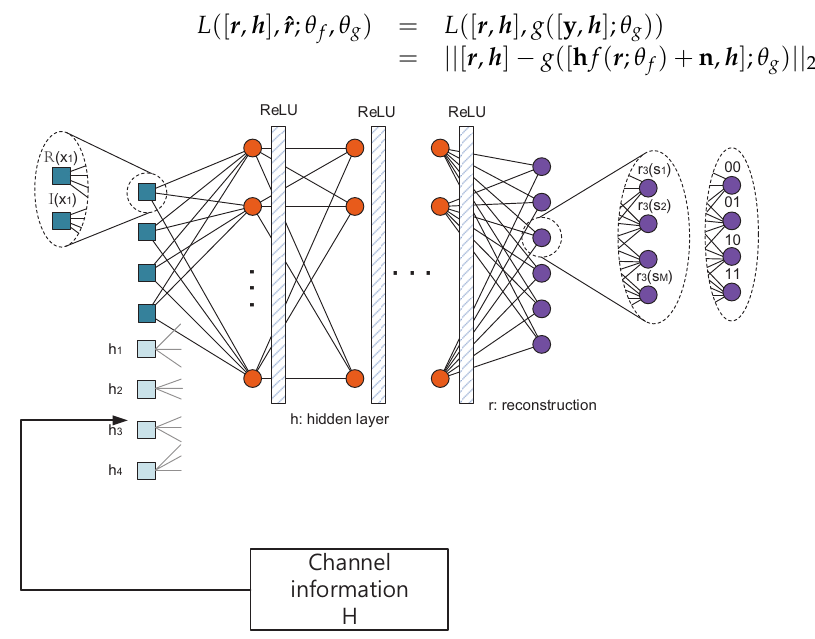
Figure 9. Channel information-aided